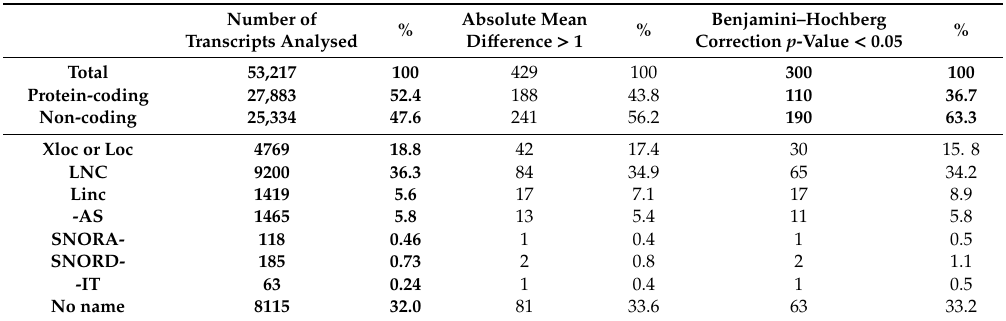
Table 2. Summary of di ff erentially expressed (DE) transcripts in non-celiac wheat sensitivity (NCWS) and